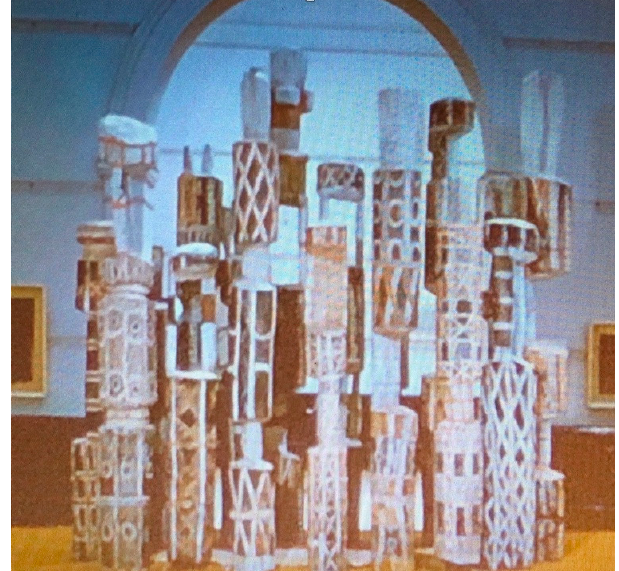
Figure 7. Pukamani grave post display by Laurie Nelson Mungatopi, Bob Apuatimi, Jack Yarunga, Charlie Kwangdini, Don Barukmadjua and an unknown artist (1958) that was exhibited with the Scougall bark paintings at the Art Gallery of New South Wales in 1960. 33 © Tiwi Designs Aboriginal Corporation incorporated/Copyright Agency, 2019.